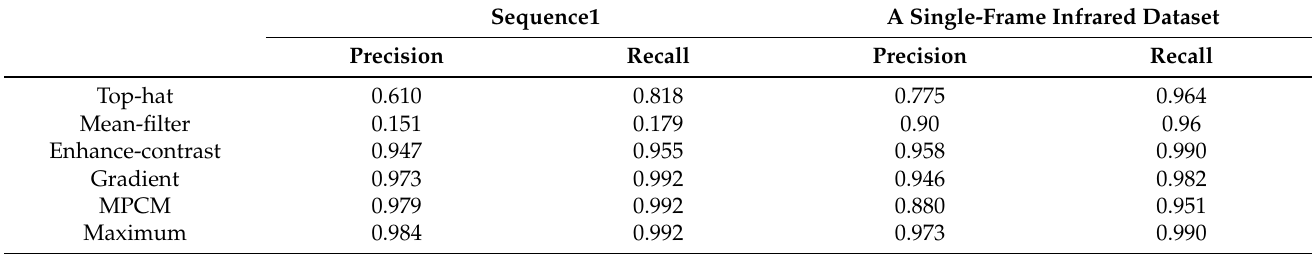
Table 1. Comparison results of accuracy and recall of different filtering methods for a single frame infrared dataset and sequence1. Sequence1